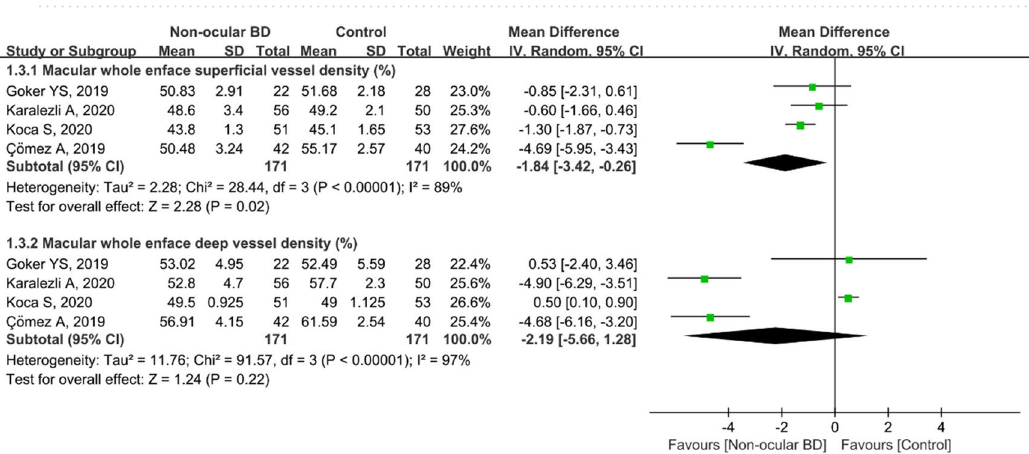
Figure 3. Forest plot analysis of macular whole enface superficial and deep vessel density between eyes with ocular BD and the controls.